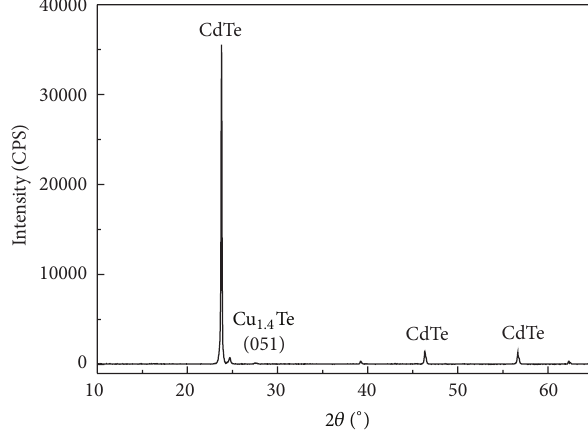
Figure 3: Transmittance and reflectance spectra for Cu 1.4 Te thin films. Table 1: Parameters for Cu Sample